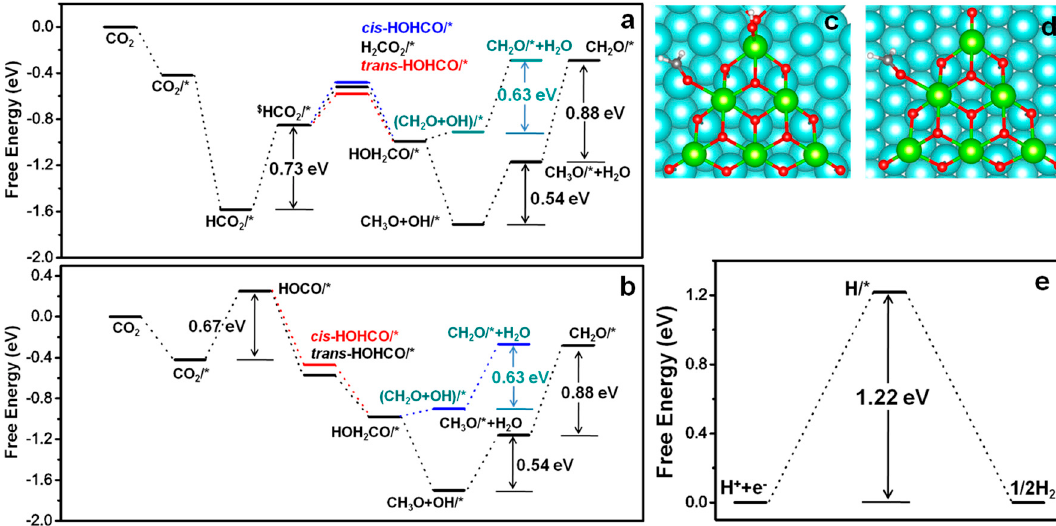
Figure 7. Free energy diagrams for the formation of acetaldehyde. ( a ) HCO 2 * path. ( b ) HOCO* path. ( c ) (CH 2 O+OH)*, ( d ) CH 2 O*, ( e ) Hydrogen Evolution Reaction (HER) on CeO x /Ag(111) catalyst.